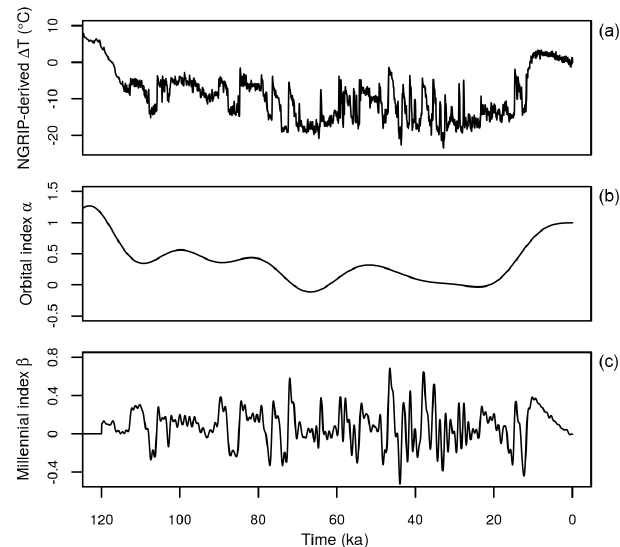
Figure 1. North Greenland Ice Core (NGRIP)-temperature anomaly reconstruction (a) used to construct the orbital-index α ( t ) (b) and the millennial-index β ( t ) (c) for the last glacial period. α ( t ) is built from the NGRIP-derived temperature anomalies (Tabone et al., 2018), filtered to remove the spectral components below the orbital period (1 /f < 18ka) and normalised between 0 and 1. β ( t ) is derived by subtracting the orbital α ( t ) index from the NGRIP- derived temperature signal, normalised between 0 and 1 and then filtered below 1ka to remove sub-millennial